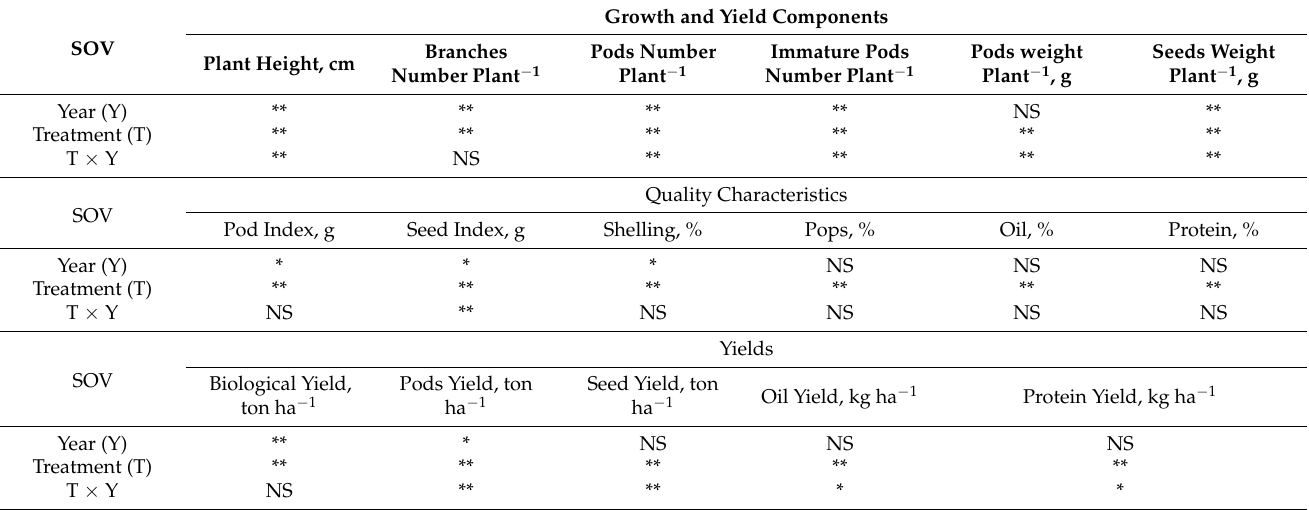
Table 4. Analysis of variance with mean squares and coefficient of variation for all of the tested traits under calcium treatments (combined data of 2015 and 2016